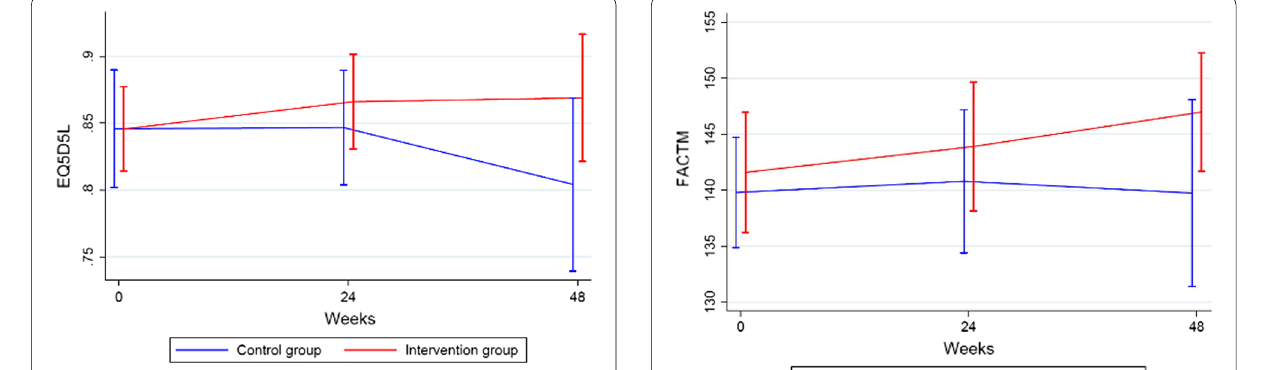
Fig. 1 EQ-5D-5L data for patients in the PROMelanoma study at baseline, week 24 and week 48, comparing the HRQoL between patients assigned to the ePRO intervention and patients who received standard care